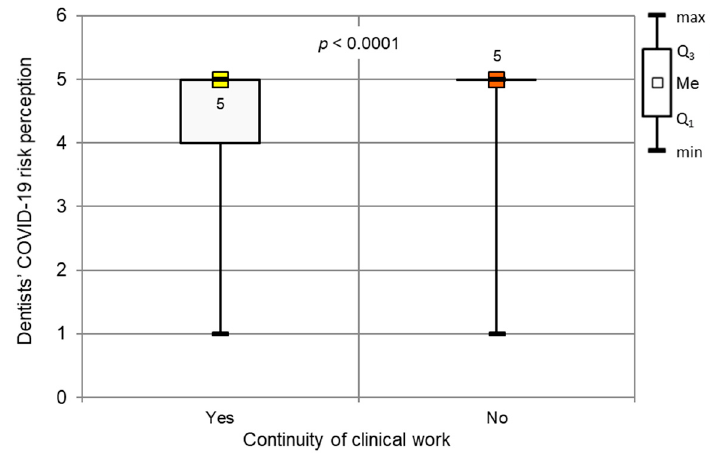
Figure 2. Continuity of clinical work during the COVID-19 outbreak vs. individual COVID-19 contraction risk assessment ( p < 0.001, Mann–Whitney test).